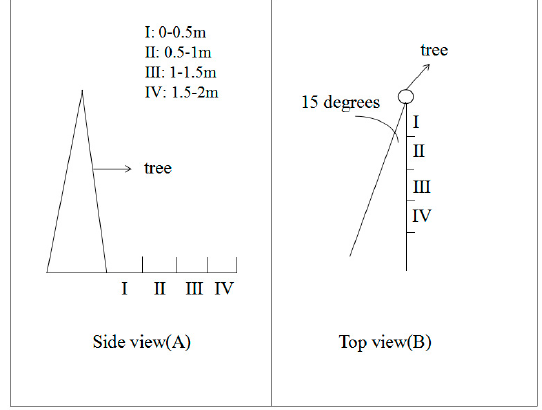
Figure 1. Schematic representation of fine root